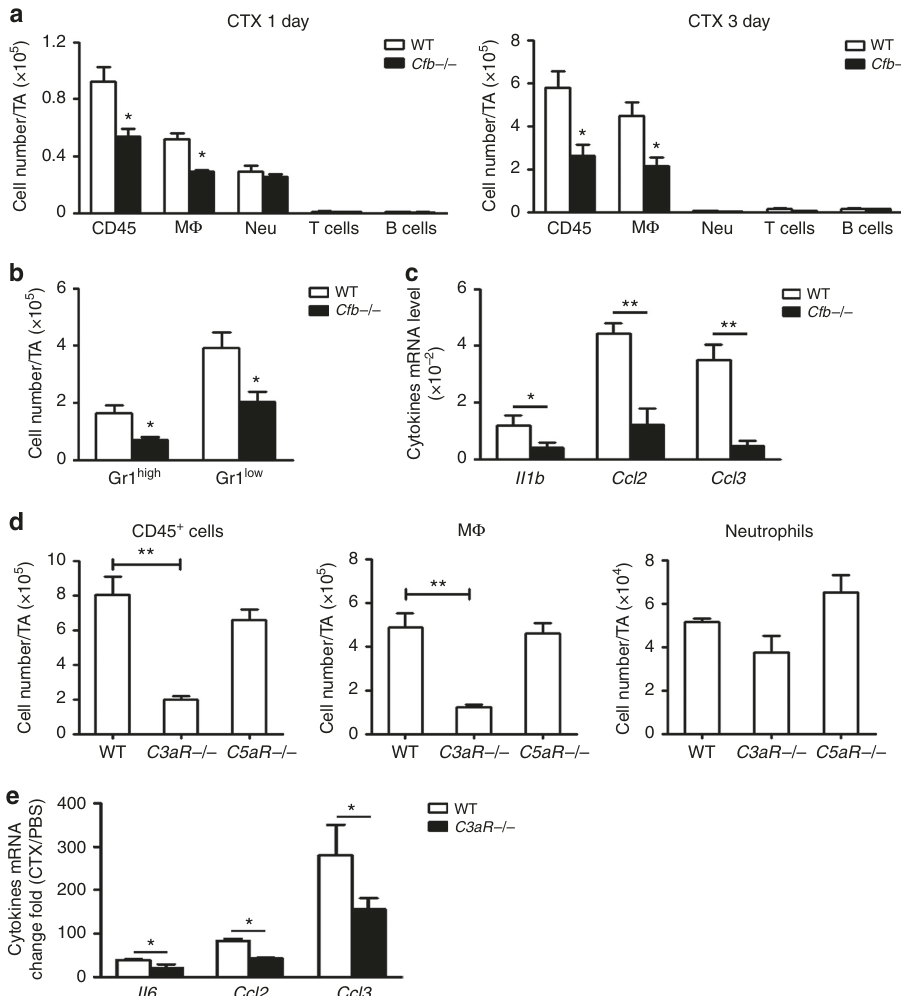
Fig. 4 Alternative pathway activation and C3aR promote macrophage in fi ltration. a At day 1 and day 3 after injury, the number of CD45 + leukocytes, Gr1 + F4/80 + macrophages, Gr1 + F4/80 − neutrophils, CD3 + T cells and B220 + B cells in muscles of WT and Cfb − / − mice were detected by FACS. The right graph indicated the percentages CD45 + cells of each group ( N = 4 in each group). b The number of Gr1 high and Gr1 low macrophages in muscles of WT and Cfb − / − mice was also analyzed. ( N = 4 in each group). c At day 3 after injury, the pro-in fl ammatory cytokines IL-1 β , CCL2, CCL3 mRNA levels in WT and Cfb − / − muscles were accessed by real-time PCR. ( N = 4 in each group). d At day 3 after injury, the number of CD45 + leukocytes, Gr1 + F4/80 + macrophages, Gr1 + F4/80 − neutrophils in muscles of WT, C3aR − / − , and C5aR − / − mice were detected by FACS. ( N = 4 in each group). e At day 3 after injury, pro-in fl ammatory cytokines IL-6, CCL2, CCL3 mRNA levels (changed fold compared with uninjured muscle) in WT and C3aR − / − muscles